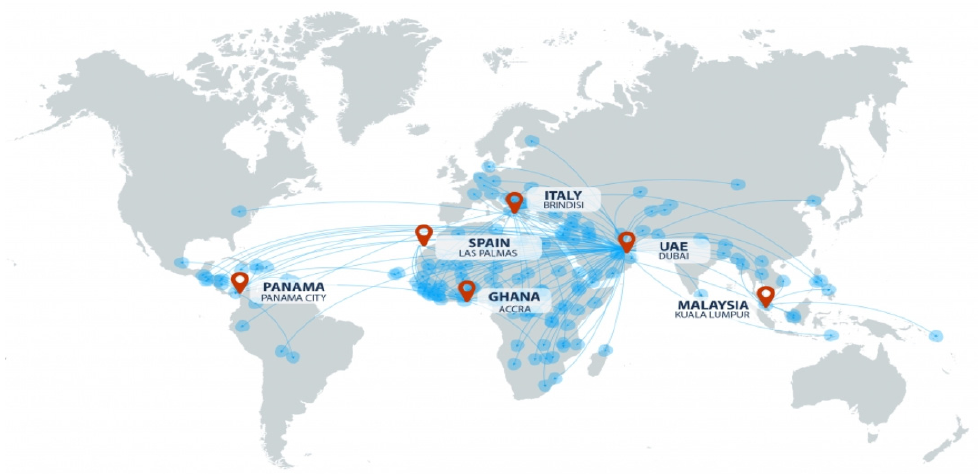
Figure 1. United Nations Humanitarian Response Depots [30].